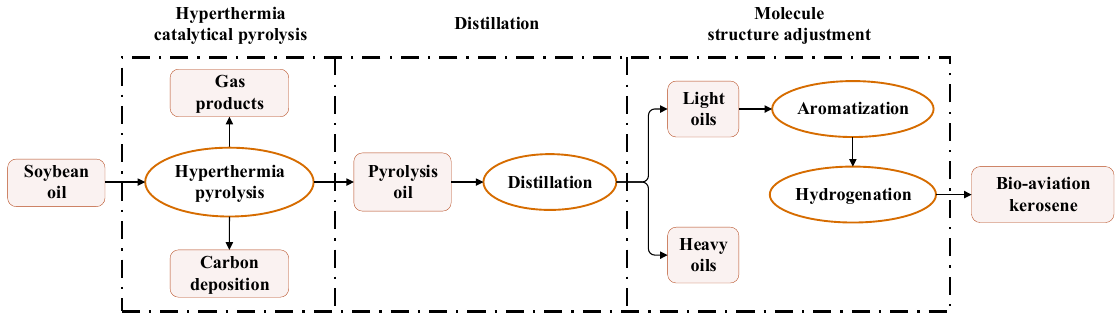
Figure 1. Technology route of the bio-jet fuel